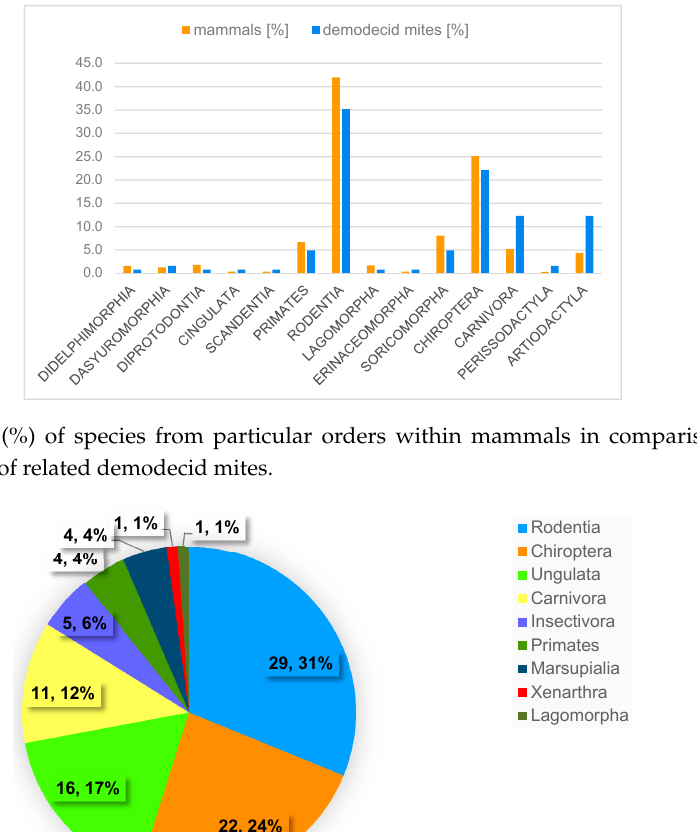
Figure 2. Geographis distribution (green dots) of Demodecidae in the world.